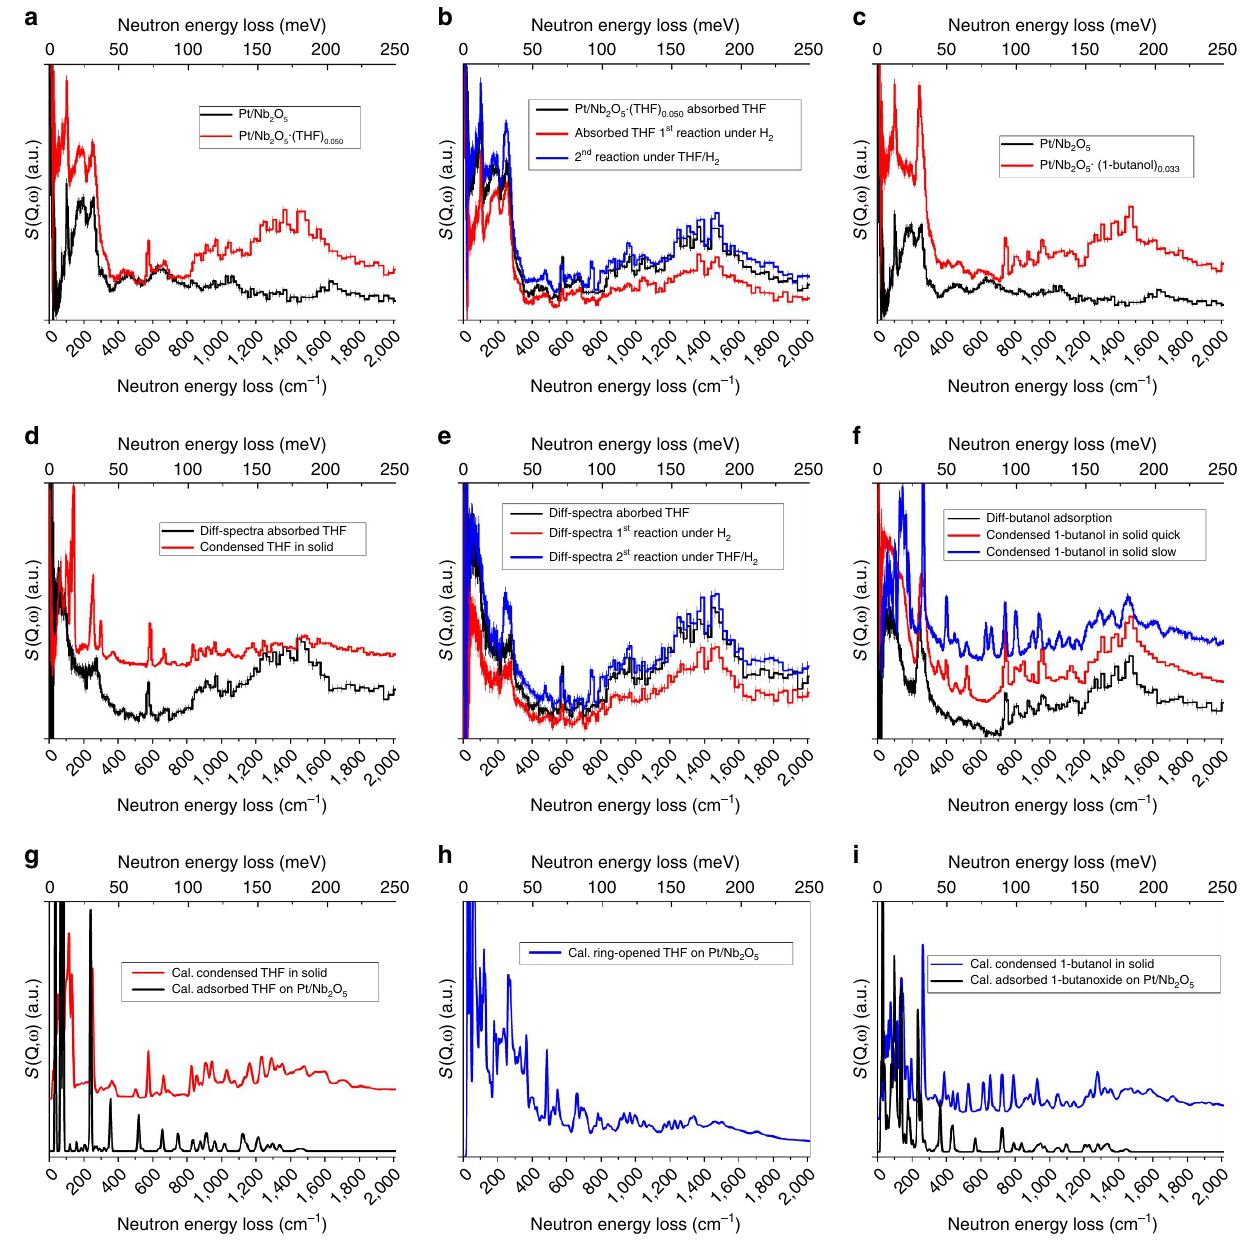
Figure 3 | Inelastic neutron scattering spectra for Pt/Nb 2 O 5 during the catalytic hydrodeoxygenation of THF. INS spectrum of the reduced catalyst was used throughout for calculations of the difference spectra. No abscissa scale factor was used throughout this report for INS calculations. NbOPO 4 has a large amount of surface –OH groups, which have no specific activity in THF conversion, but will generate additional INS peaks overlapping with signals from substrates. Pt/Nb 2 O 5 has a similar catalytic reactivity as Pt/NbOPO 4 for the hydrodeoxygenation of THF and was therefore used in INS study instead. Comparison of the experimental INS spectra for bare catalyst and the THF ( a ) and 1-butanol ( c ) adsorbed catalyst. Comparison of the difference plots for experimental INS spectra of bare and THF ( b ) and 1-butanol ( f ) adsorbed catalyst, and the experimental INS spectra of condensed THF ( d ) and 1-butanol ( f ) in the solid state. ( b ) Comparison of the experimental INS spectra for the two hydrodeoxygenation reactions of adsorbed THF on the catalyst, and difference plots (with reduced catalyst as background) are shown in ( e ). The first reaction was carried out at 130 (cid:2) C in pure H 2 flow for 10min and the second reaction was carried out at 130 (cid:2) C in THF/H 2 flow for 5h, that is fresh THF vapour was fed into the reaction cell continuously with H 2 as carrier gas during the reaction. ( g ) Comparison of the calculated INS spectra for condensed THF in solid and adsorbed THF on the catalyst. ( h ) View of the calculated INS spectrum for ring-opened THF on the catalyst. ( i ) Comparison of the calculated INS spectra for condensed 1-butanol in solid and adsorbed 1-butanoxide on the adsorbed THF molecules are disordered over the catalyst surface, motion on adsorption. The peak at 300 cm (cid:2) 1 , likely due to the and have restricted translational motion owing to the strong combination of the lattice mode at B 60 cm (cid:2) 1 and the strong mode at 251 cm (cid:2) 1 , concurrently reduced in intensity. In binding to the catalyst. The very strong peak at 251 cm (cid:2) 1 , assigned to the torsional mode of the C2–C3 bond of THF ring, addition, the ring deformation mode at 587 cm (cid:2) 1 in solid THF shifts to 571 cm (cid:2) 1 when adsorbed on the catalyst. A structural reduced significantly in intensity, indicating the loss of this